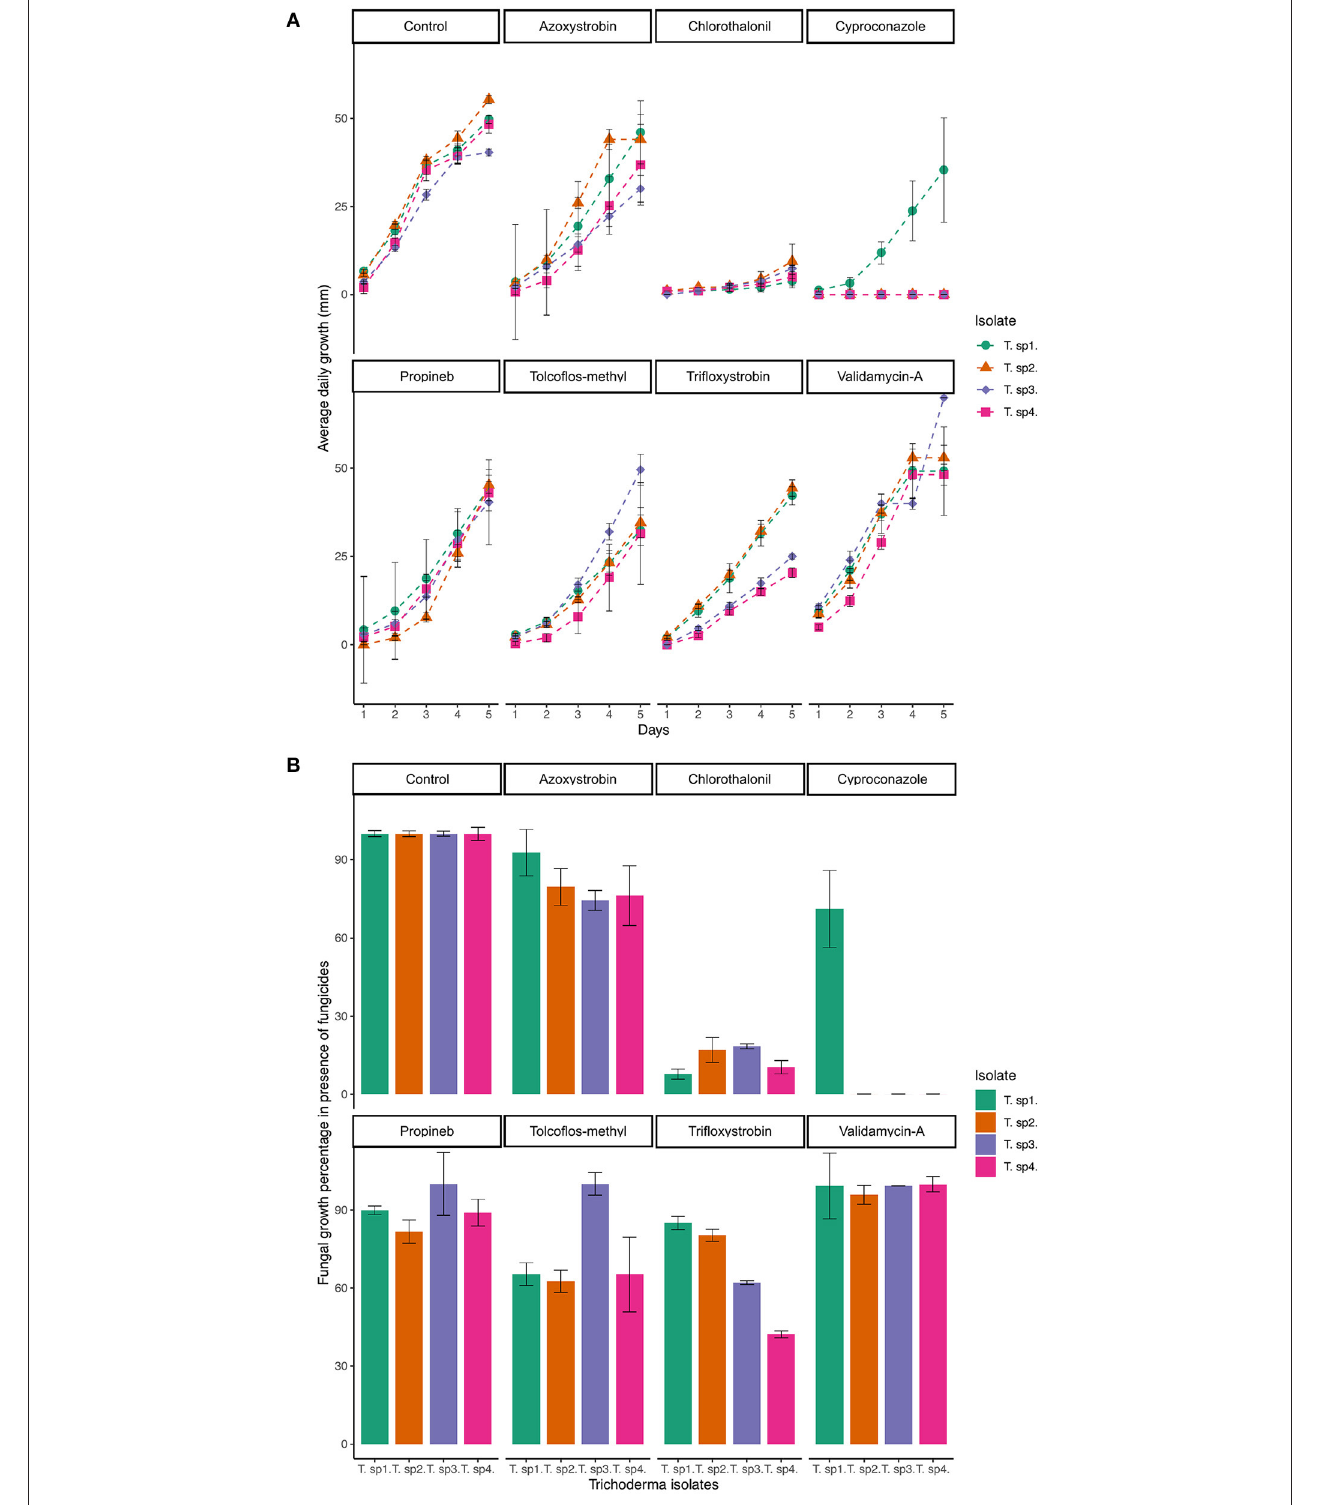
FIGURE 1 | (A) Average daily growth of Trichoderma replicates during 5 days. Average was calculated using five replicates per fungicide. (B) Fungal growth percentages with respect to the control, in the presence of different fungicides in PDA.